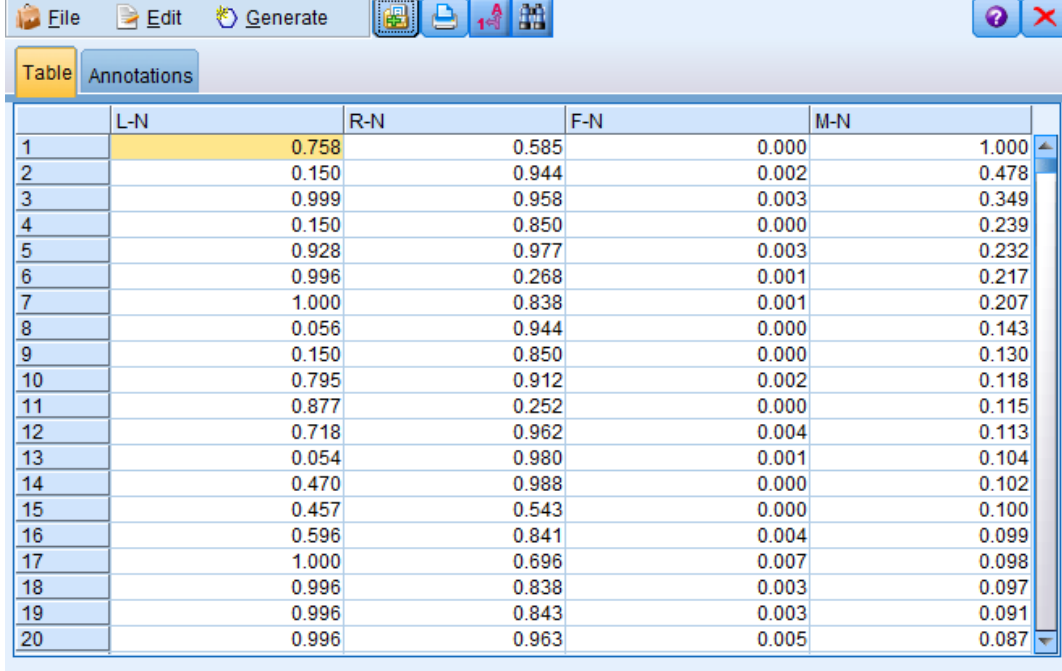
Figure 3. Customer records in